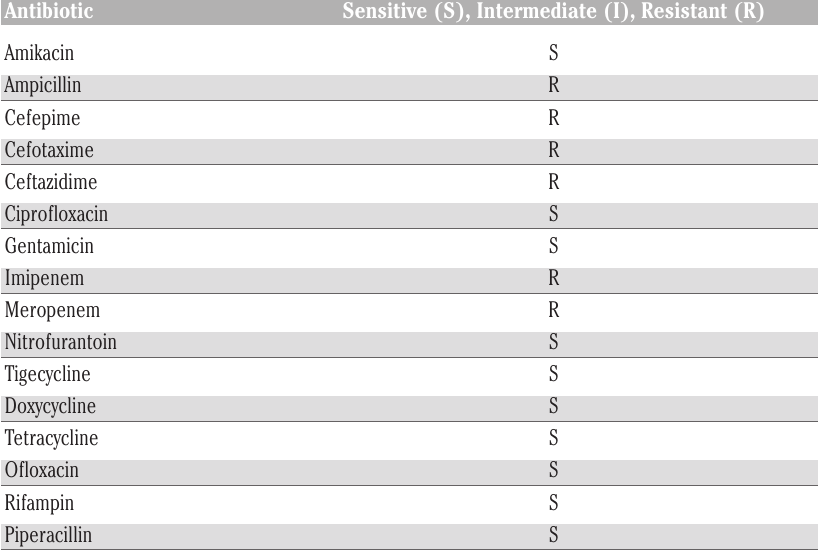
Table 1. Blood culture results and susceptibility testing for Pasteurella multocida . Result: positive. Micro-organism: Pasteurella multocida . Antibiotic Sensitive (S), Intermediate (I), Resistant (R)